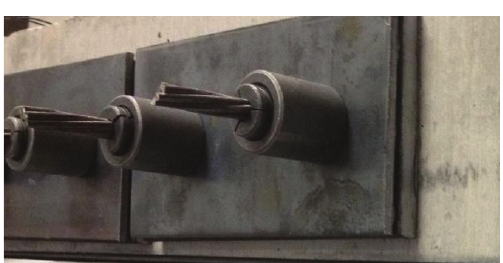
Figure 16: Live end